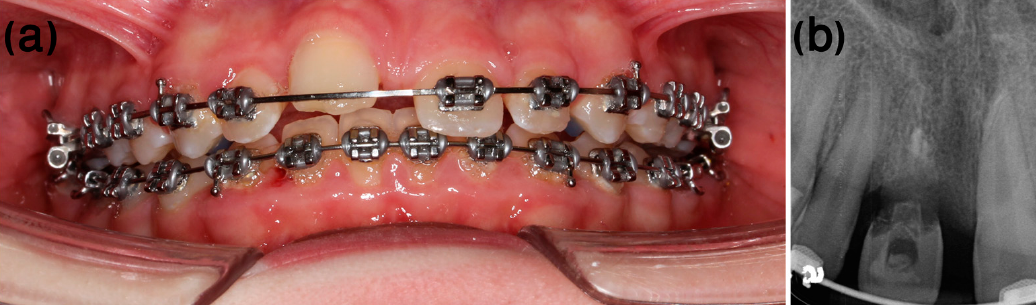
Figure 12. Case 2, day of decoronation, pre-op. ( a ) Clinical and ( b ) radiographic appearance on the day of decoronation, prior to the procedure (the white rotated symbol “a” in the bottom left corner of the figure is part of an embedded symbol in the phosphorus plate by the manufacturer for orientation).